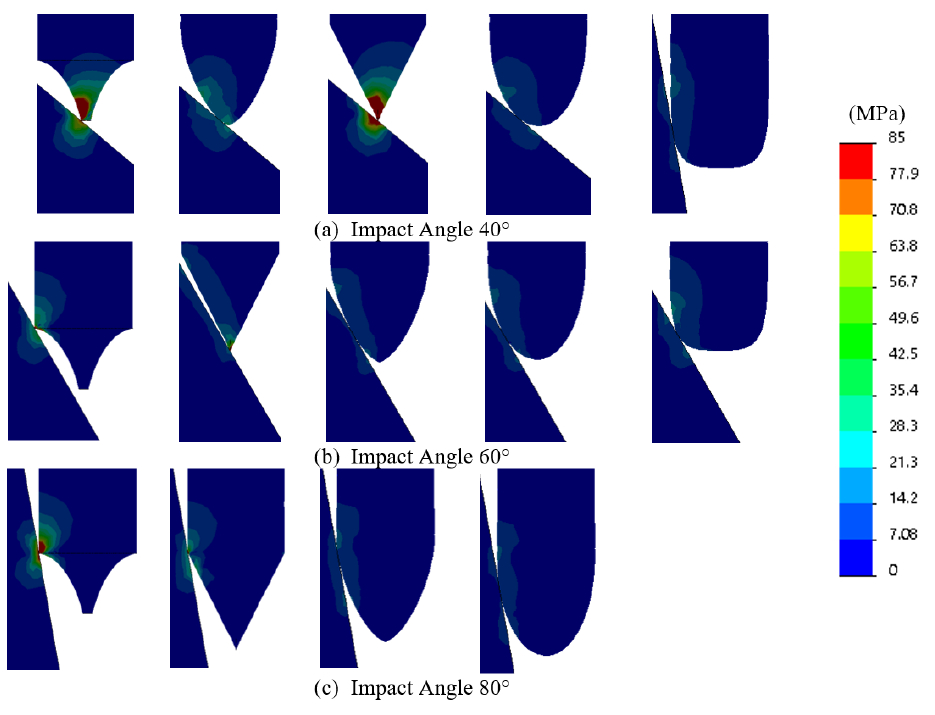
Figure 3. Tip FEA analysis.